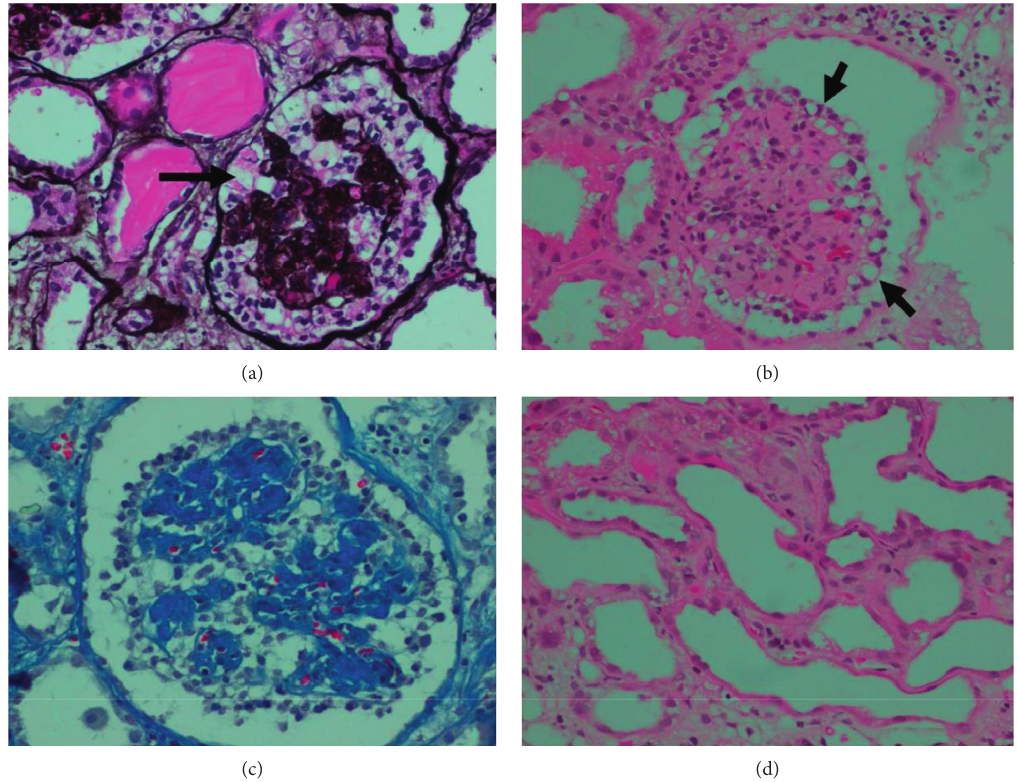
Figure 1: Kidney biopsy: representative light microscopy shows global collapse of the glomerular capillary loops accompanied by hy- perplasia and hypertrophy of overlying glomerular epithelial cells (a–c) many of which contain scattered eosinophilic protein droplets (a, arrow) and numerous intracytoplasmic vacuoles (b, arrows). a: Jones methenamine silver stain; b: H&E stain; c: Masson’s trichrome stain, × 400. Acute tubular injury is manifest in many cortical tubules, accompanied by interstitial edema and patchy interstitial mononuclear inflammatory infiltrates (d: H&E stain, ×